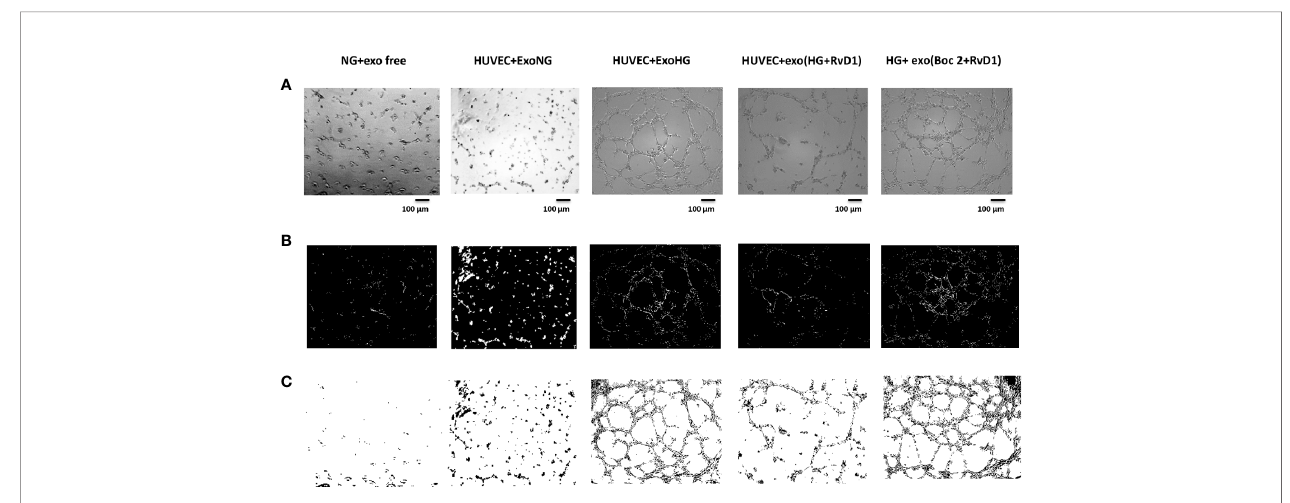
FIGURE 7 | Representative images of the tubular structures from non-transfected HUVEC cells. (A) Matrigel natural views, (B) dark fi eld Matrigel views and (C) Matrigel graphical images of HUVEC cells grown in normal glucose (NG, 5 mM) seeded with: exosome-free medium (NG-exofree); standard medium containing exosomes released after stimulation of photoreceptors with Normal Glucose (NG, 5 mM) (NG + exoNG); standard medium containing exosomes released after stimulation of photoreceptors with High Glucose (HG, 35 mM) (NG + exoHG); standard medium containing exosomes released after stimulation of photoreceptors with HG + RvD1 (50 nM) (NG + exoHG-RvD1); standard medium containing exosomes released after stimulation of photoreceptors with HG + RvD1 + Boc2 (20 m M) (NG + exoHG-RvD1 + Boc2). Scale bar 100 m m. Magni fi cation